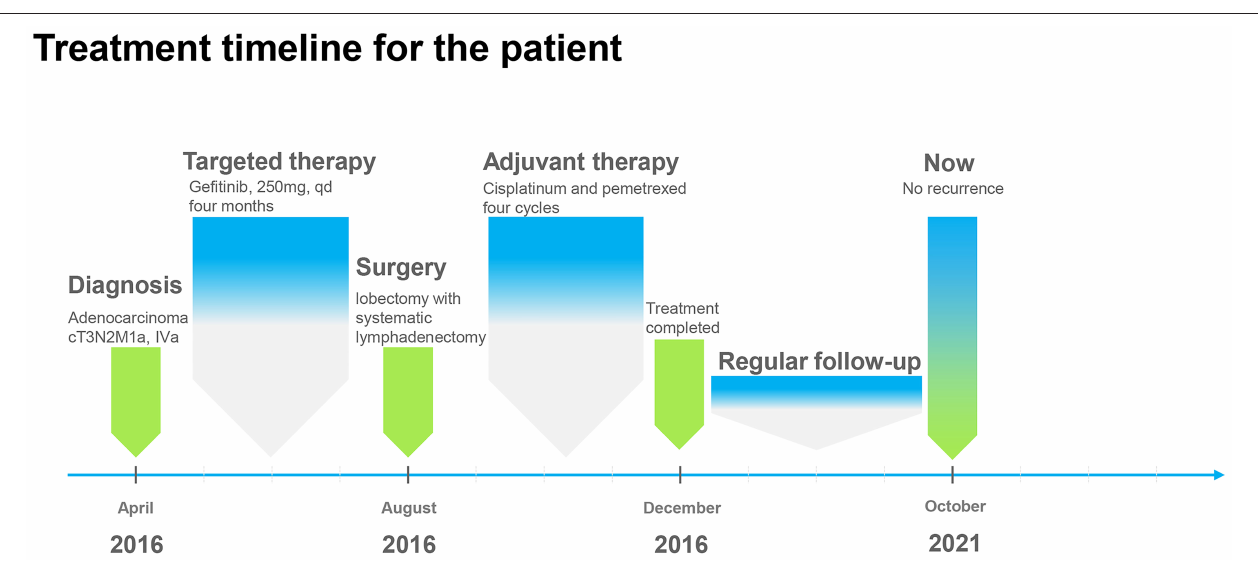
FIGURE 4 | Treatment timeline of the patient in our case.